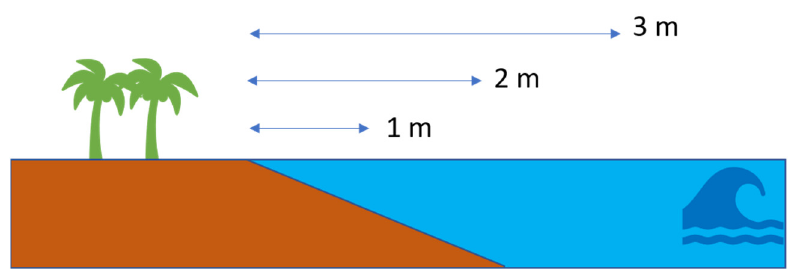
Figure 1. Seawater sampling at Pontian seaside.